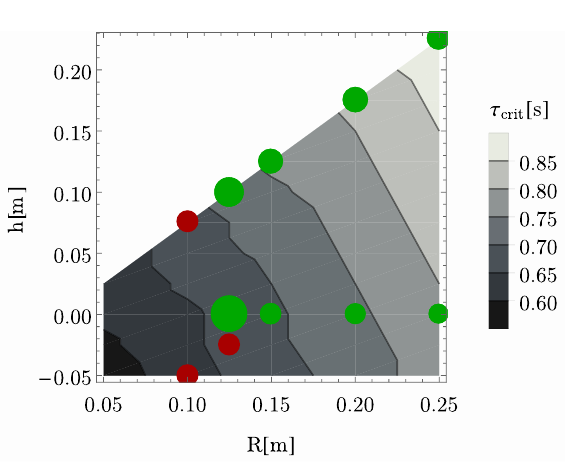
Figure 7. Phase portrait of the balance board angle, data filtering, and the fitted ellipse.